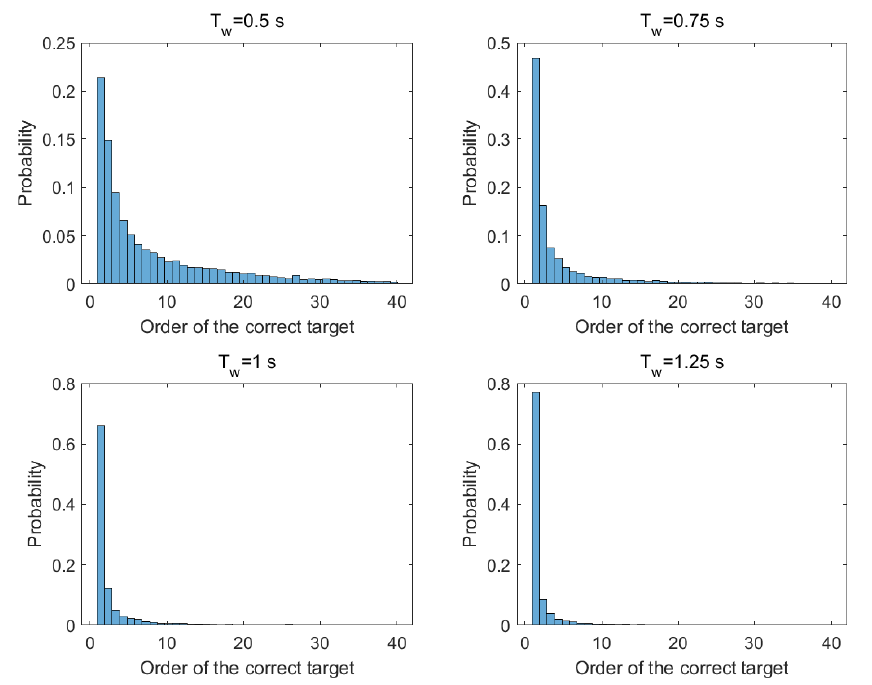
Figure 1. The statistical probability of the correct label position in the sort under different data lengths.